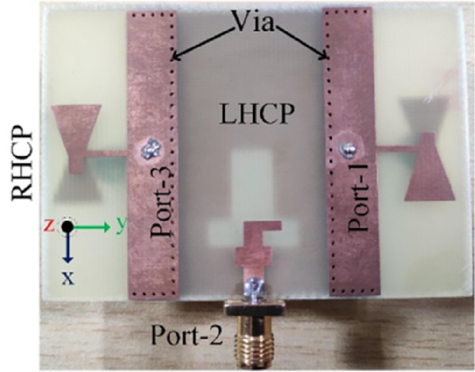
Figure 22. Fabricated circularly polarized MIMO antenna [72].